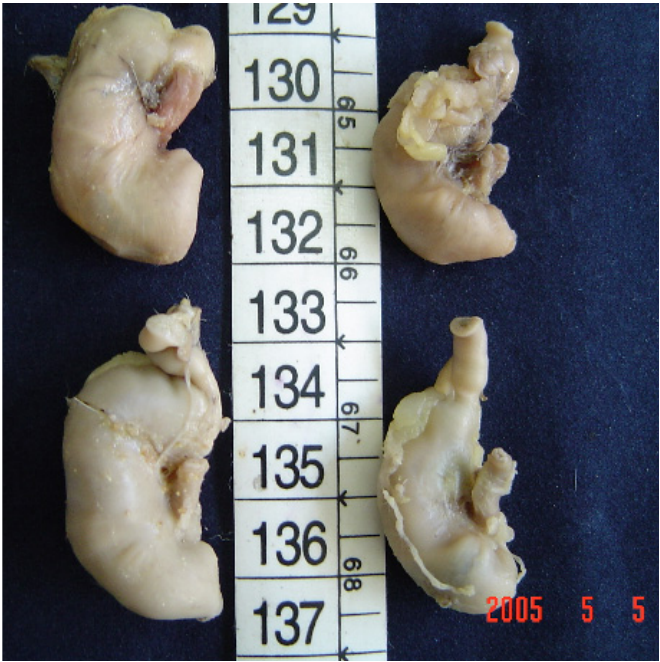
FIGURE 2 – Stomachs extracted from the abdominal cavity revealing the external macroscopic anatomy of the rats. Examples of group I on the right and group II on the left can be observed